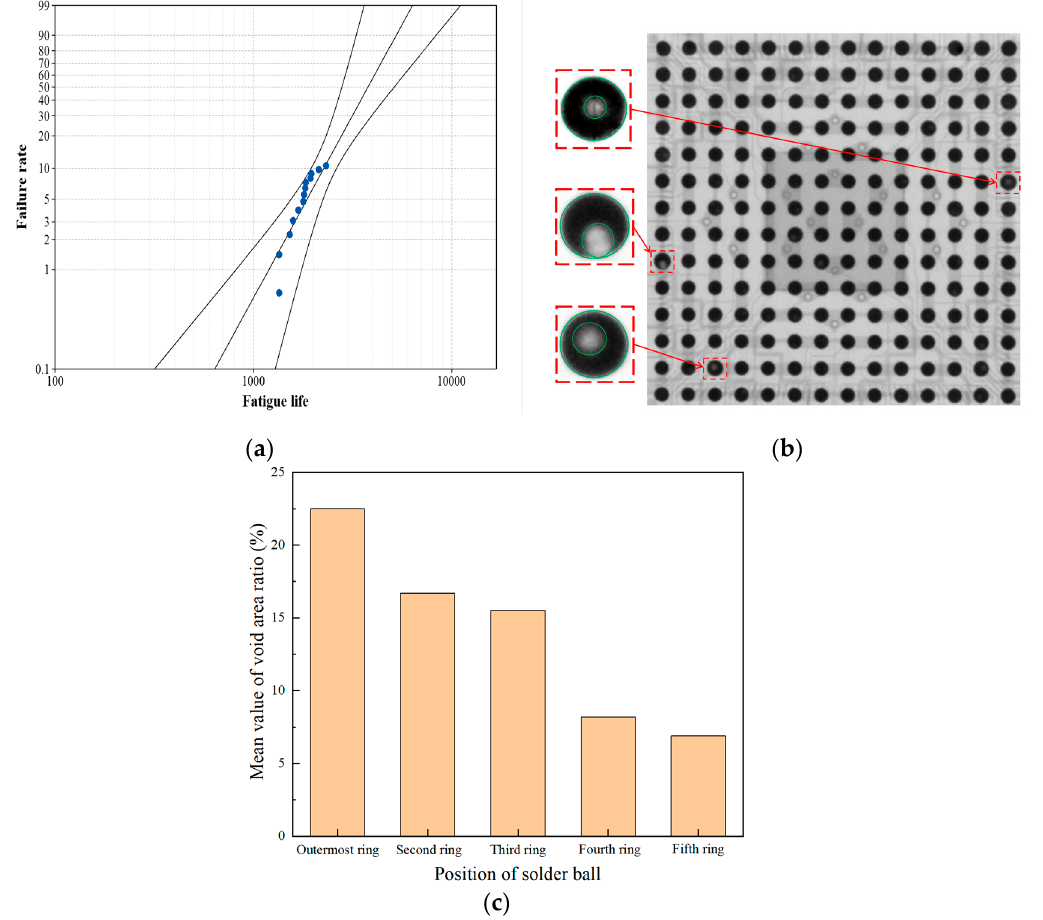
Figure 4. ( a ) Weibull distribution of failure life. ( b ) X-ray flaw detection image after temperature cycling test, ( c ) Mean void area ratio in X-ray images.